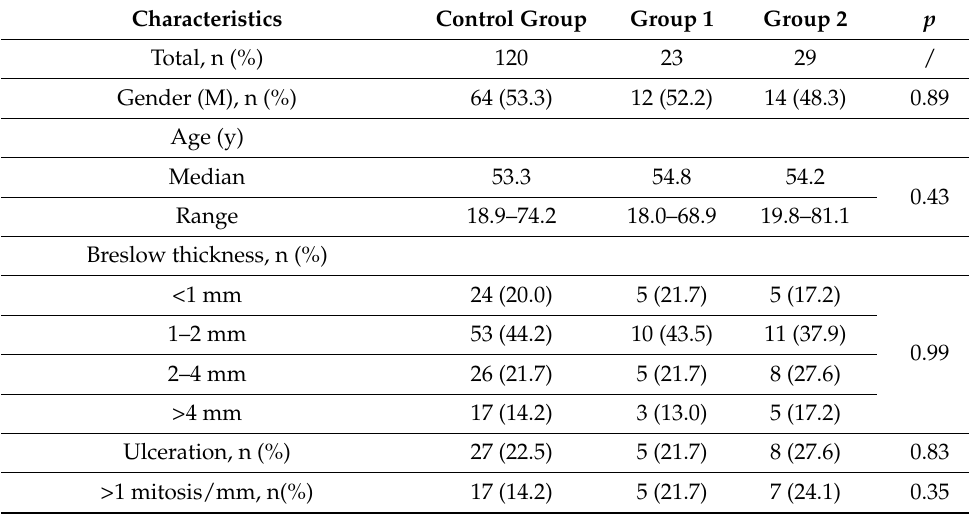
Table 1. Characteristics of subjects that underwent